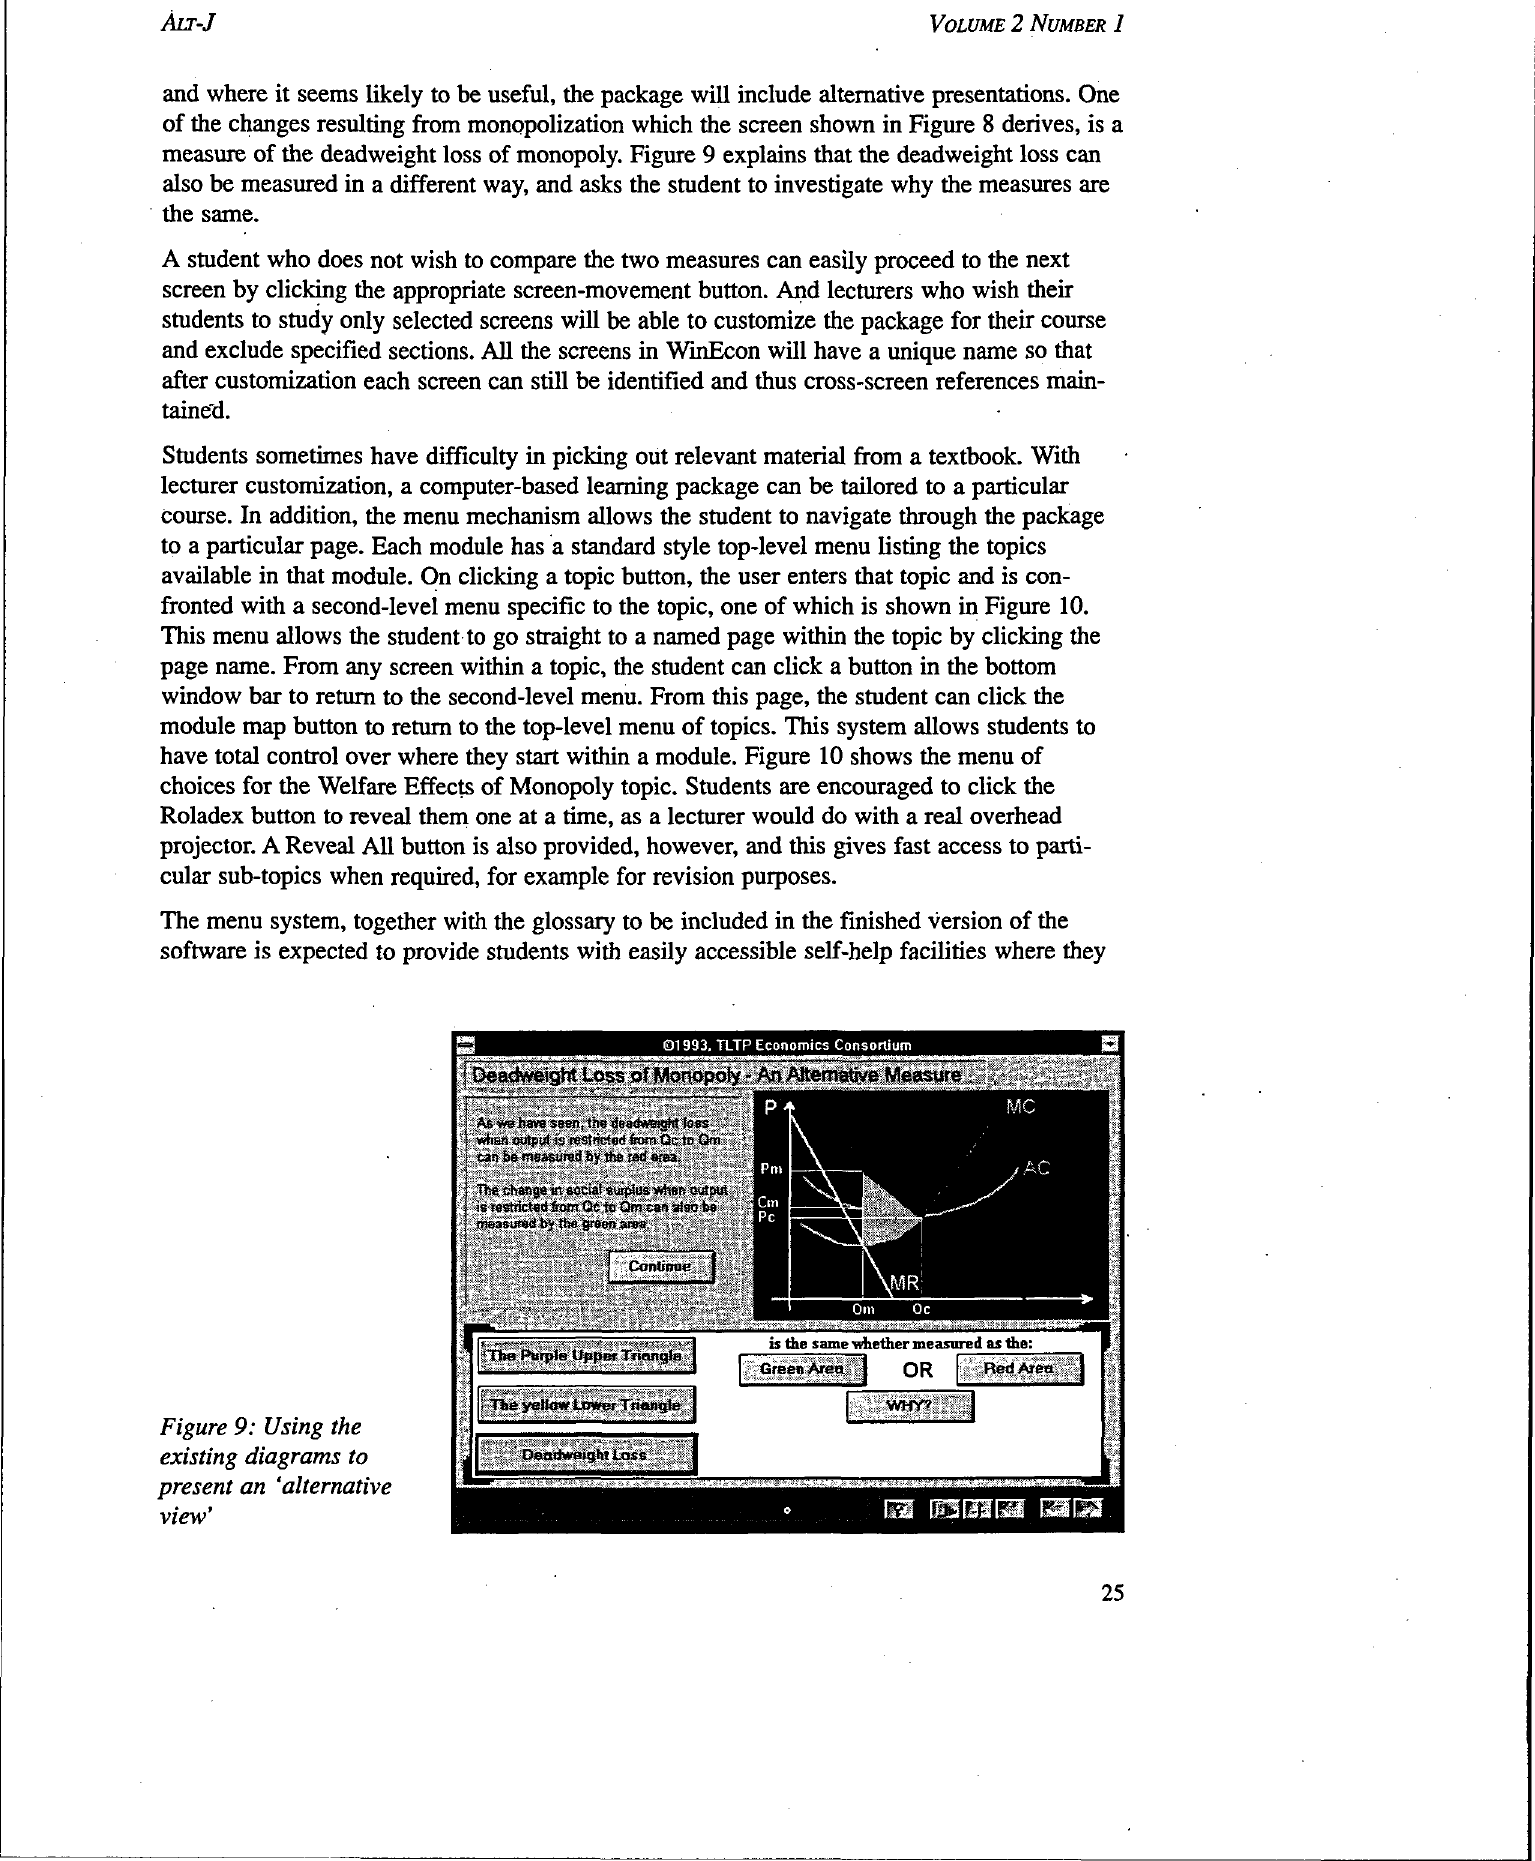
01993. TLTP Economics